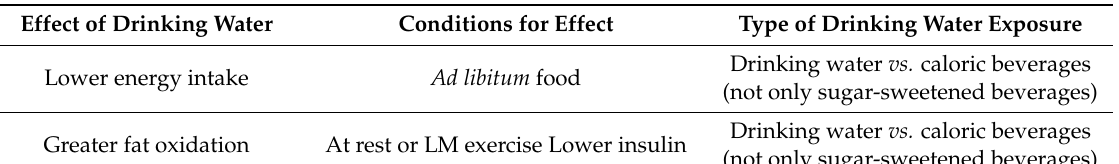
Table 7. RCT conditions where short-term effects of drinking water favor weight management. RQ, respiratory quotient.